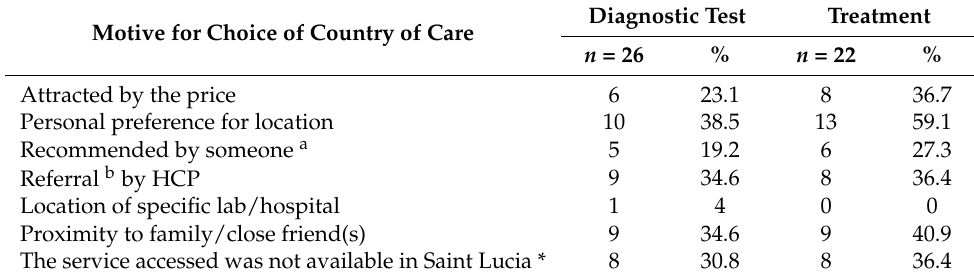
Table 4. Frequency of motive for seeking care outside of Saint Lucia.